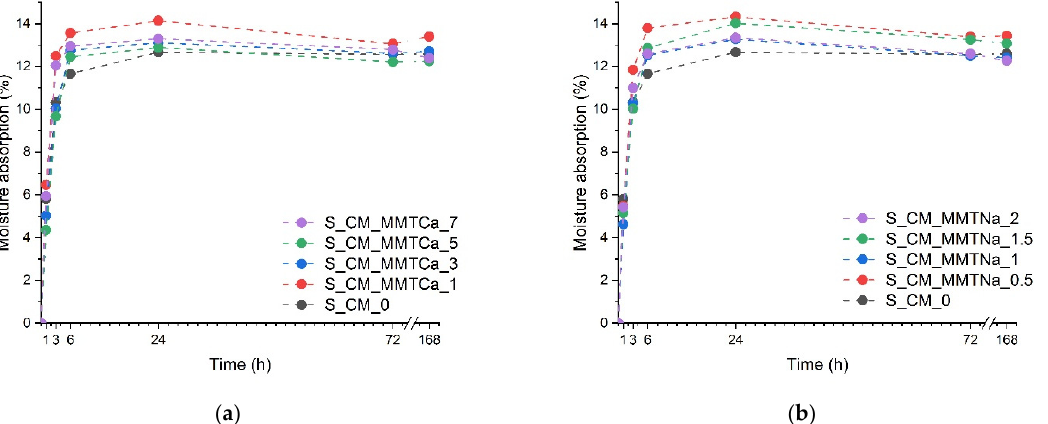
Figure 6. Water absorption of starch films containing ( a ) calcium montmorillonite, and ( b ) sodium Figure 6. Waterabsorptionofstarchfilmscontaining( a )calciummontmorillonite,and( b montmorillonite.